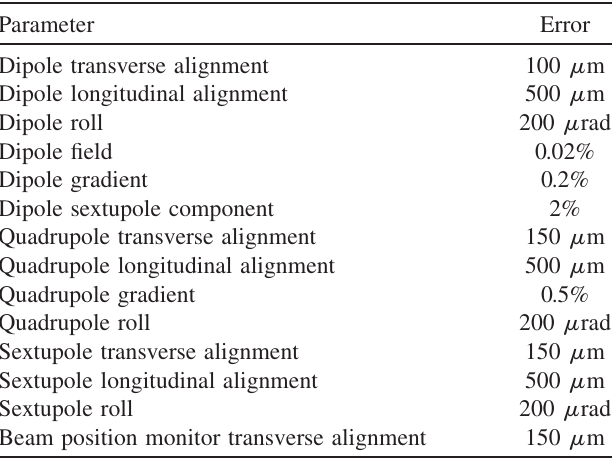
TABLE I. Errors used in simulating the